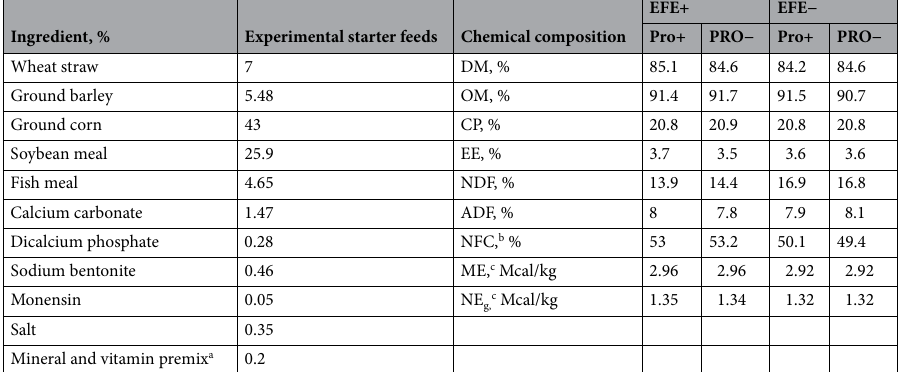
Table 1. Experimental diets ingredients and chemical composition. a Contained per kilogram of supplement: CP: 290 g; EE: 65 g; ME: 9.66 MJ; NE G : 3.56 MJ; NDF: 175 g; Ca: 6.50 g; P: 7.70 g; non-fiber carbohydrate (NFC): 290 g; Mg: 2 g; K: 0.99 g; Na: 1.6 g; Cl: 0.1 mg; Co: 23 mg; Mn: 43 mg; Se: 0.1 mg; Zn: 43 mg; Vitamin A: 12,000 IU; Vitamin D: 5,000 IU; Vitamin E: 100 IU. b Calculated as [DM − (NDF + CP + ether extract + ash)] (NRC, 2001). c Estimated using NRC (2001) equations with the values from the analyses for